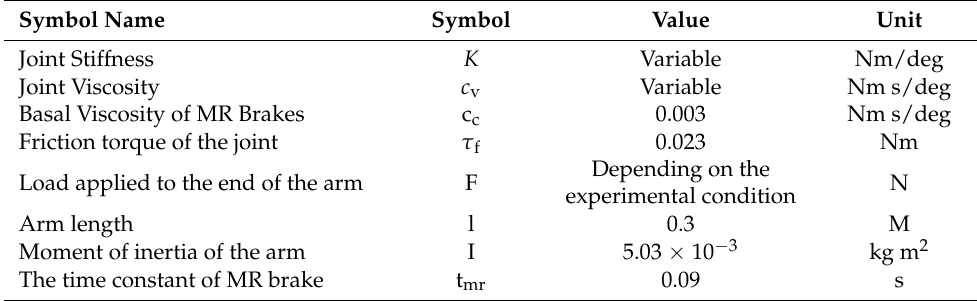
Figure 16. Simulation model of disturbance response experiment. Table 3. Parameters used in the simulation of the characterization experiment.